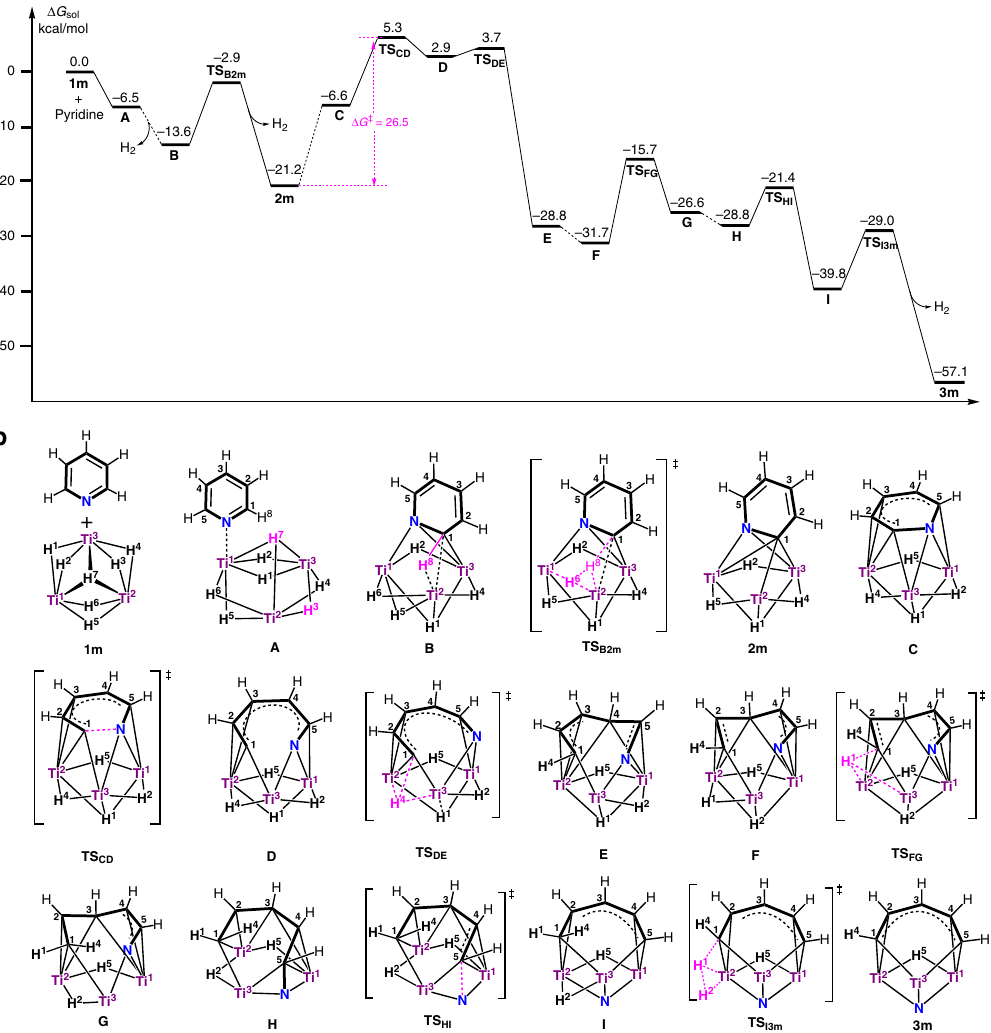
Fig. 4 Computational analysis of the reaction of 1 with pyridine. a Simpli fi ed energy pro fi le for the reaction of 1m (a model of 1 ) with pyridine. b Structures of the stationary points shown in the energy pro fi le. The C 5 H 4 SiH 3 ligands have been omitted for clarity. The Gibbs free energies (kcal/mol) in solution are relative to the energy sum of 1m and pyridine. The complex name with TS means transition state. The dashed line connected to two stationary points in the energy pro fi le means that the detailed transformations involved in the corresponding steps have been omitted for clarity and are given in Supplementary Figs. 58